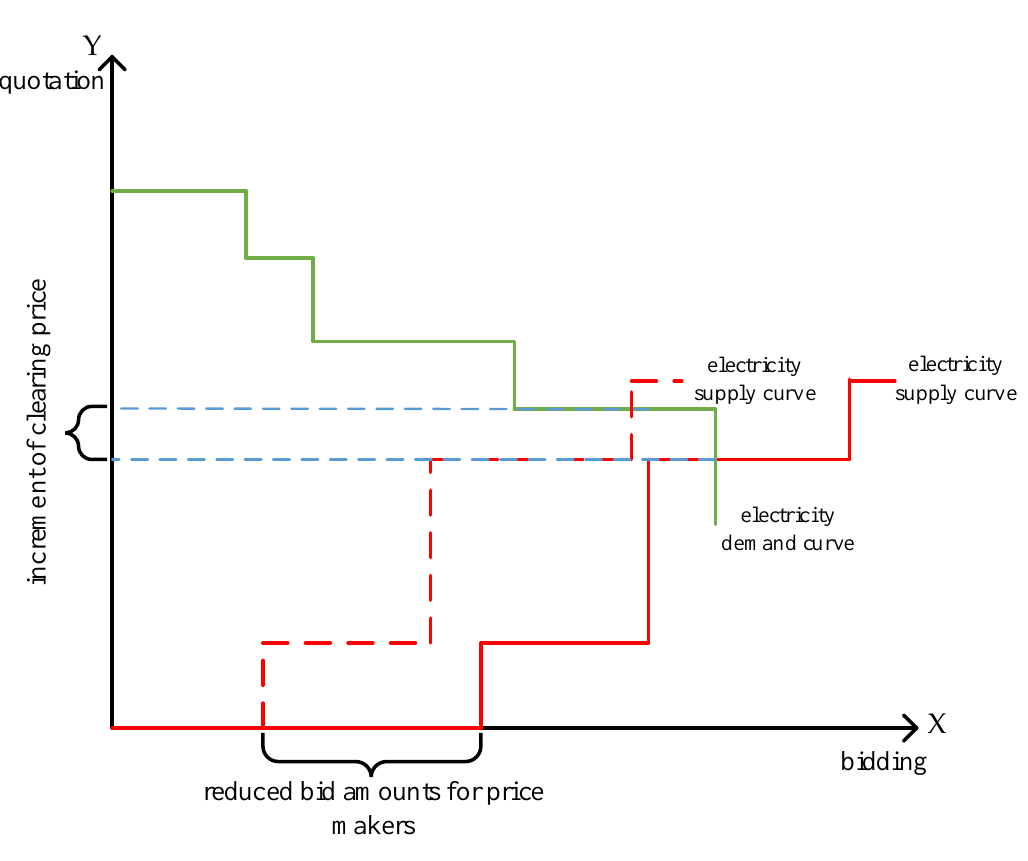
Figure 1. Demand and supply in the electricity wholesale market.